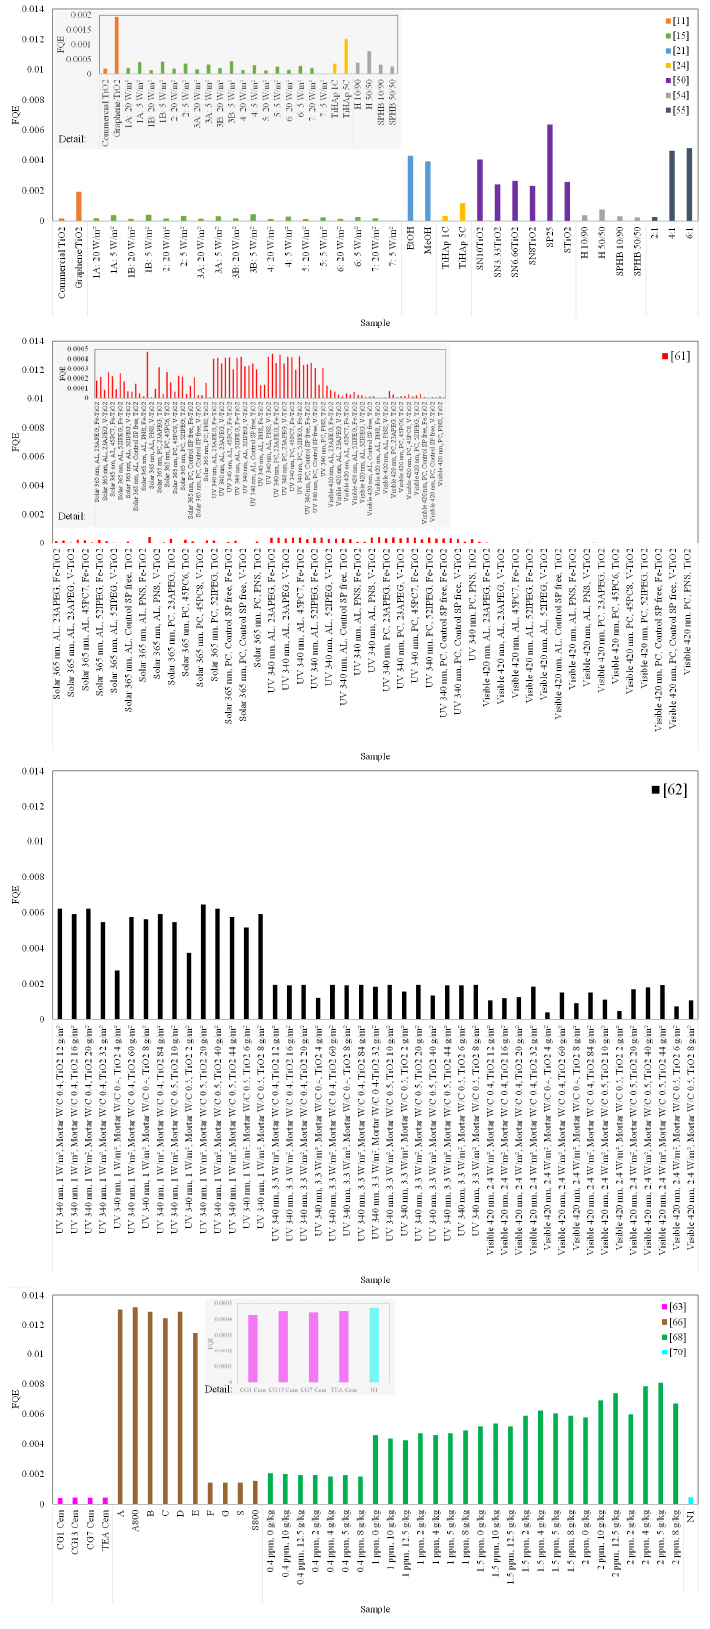
Figure 8. Formal quantum efficiency (FQE) determined for the samples of the papers discussed on depollution effects of thin TiO 2 -based coatings applied on mortars